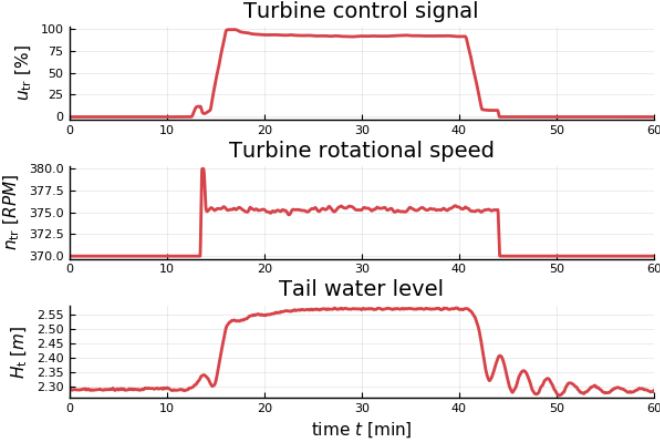
Figure 2. Measurements of the experimental